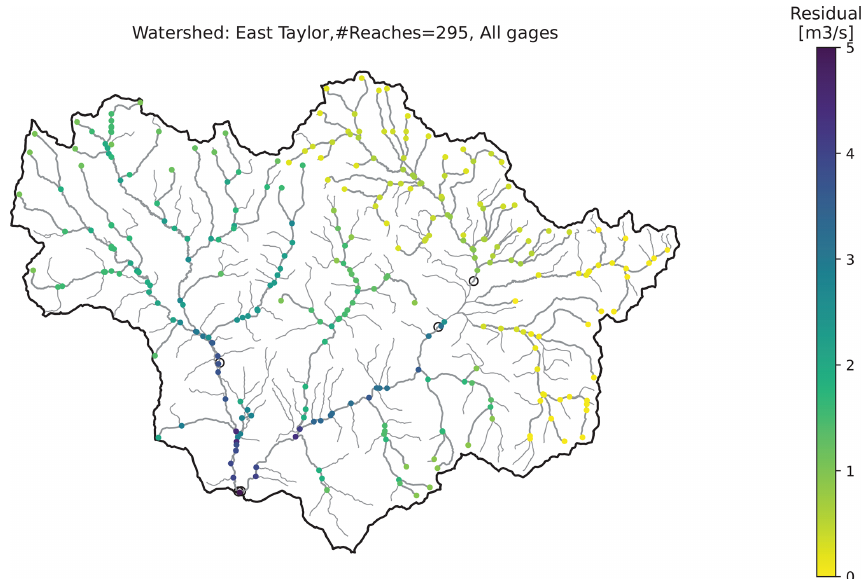
Figure 9. Residuals resulting from the data fusion using all five USGS gages. The greatest correction effect is seen at the downstream points.